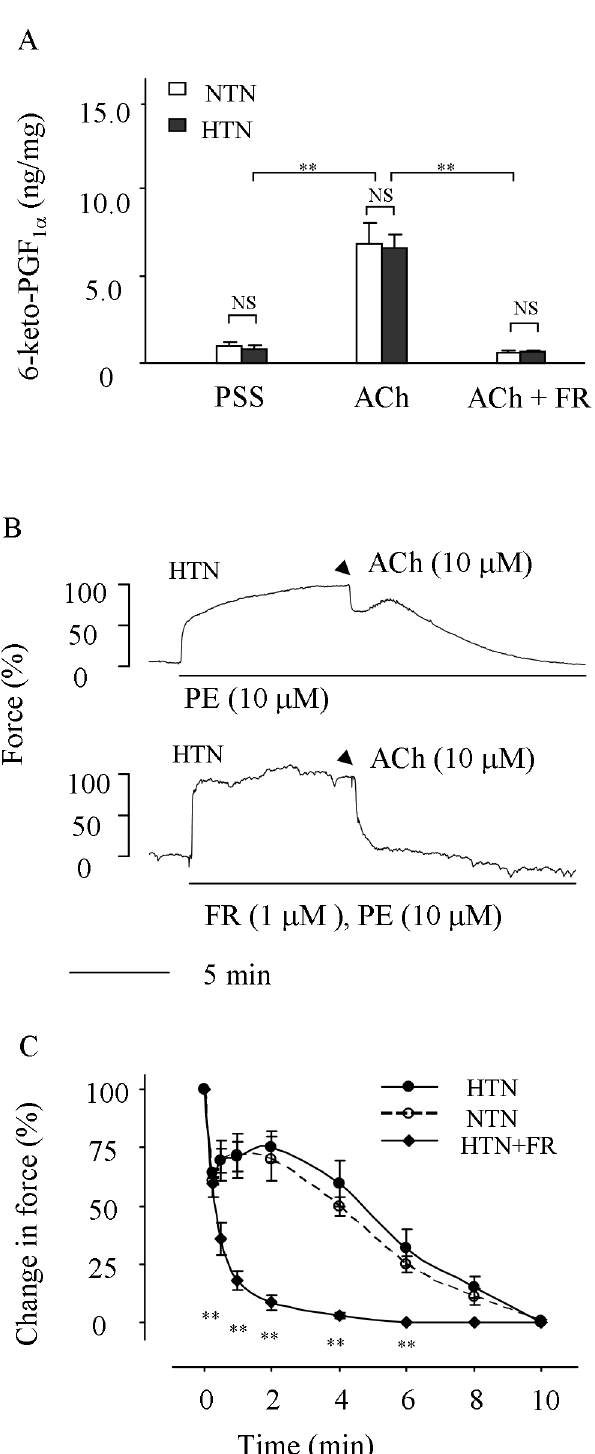
Fig 1. PGI 2 synthesis and response evoked by ACh in 2K1C hypertensive carotid arteries. A : detection of the PGI 2 metabolite 6-keto-PGF 1 α evoked by ACh with EIA in 2K1C hypertensive (HTN) and control normotensive (NTN) arteries with/out the presence of 1 μ M COX-1 inhibitor FR122047 (FR). Values were expressed as mean ± SEM (n = 6 for each). ** P < 0.01; NS, not significant. B : represent traces showing time- courses of the relaxation evoked by ACh (10 μ M) in HTN pre-contracted with PE (10 μ M) and that obtained in